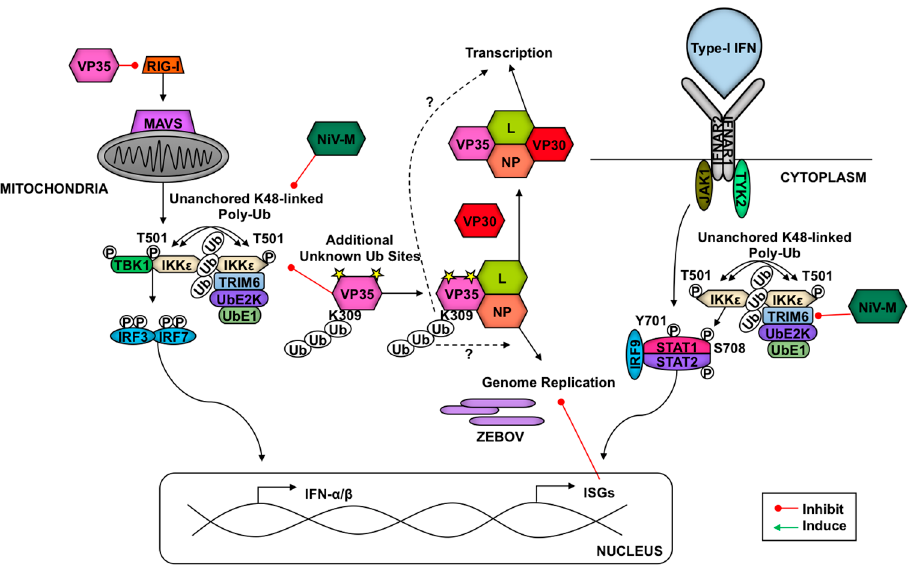
Figure 6. TRIM6 is targeted by Nipah and Ebola viruses to enhance virus replication. Ebola virus (EBOV) inhibits type-I IFN production by multiple mechanisms. EBOV VP35 binds and inhibits RIG-I, IKK ε , and TBK-1 to inhibit IFN production. TRIM6 ubiquitinates VP35 on K309 and promotes VP35 activity as the cofactor of the viral polymerase and enhances virus replication. Additional unidentified ubiquitination sites of VP35 exist. Whether TRIM6 enhances EBOV replication by promoting viral genome replication or viral gene transcription is not known. In Nipah virus infection, the viral matrix protein (NiV-M) promotes TRIM6 degradation, resulting in reduced synthesis of K48-linked unanchored polyubiquitin chains, IKK ε oligomerization, IKK ε -T501 autophosphorylation, IRF3 phosphorylation, and reduced IFN induction. These combined losses confer an impaired host-antiviral response.